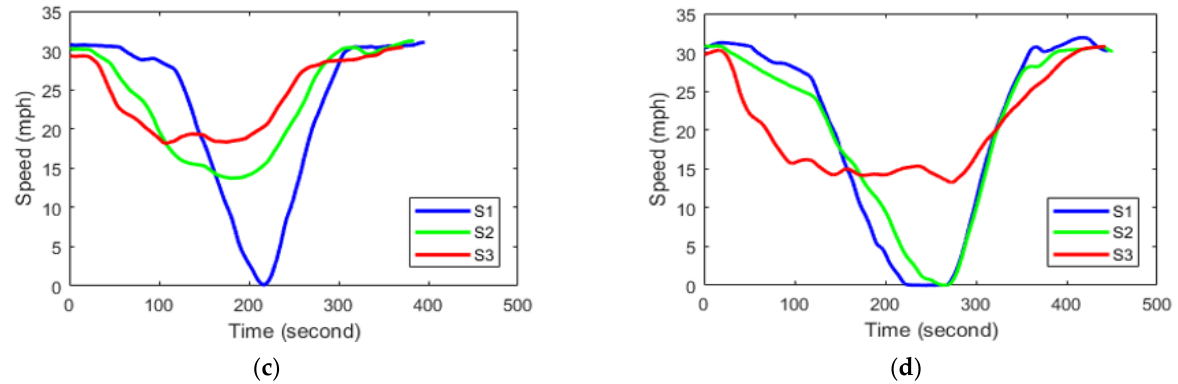
Figure 7. Vehicle speed profiles of a selected participant for the downhill direction under various red offset timings: ( a ) 10 s; ( b ) 15 s; ( c ) 20 s; ( d ) 25 s.